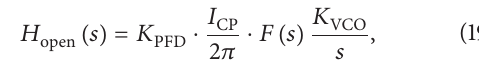
converter (TSSSBC) has been developed and analyzed with eight modes [20]. Figure 4 shows the equivalent circuit diagram for various modes of operation of SSSSBC. For TSSSBC, the same is applicable with a phase shift of 120 ∘